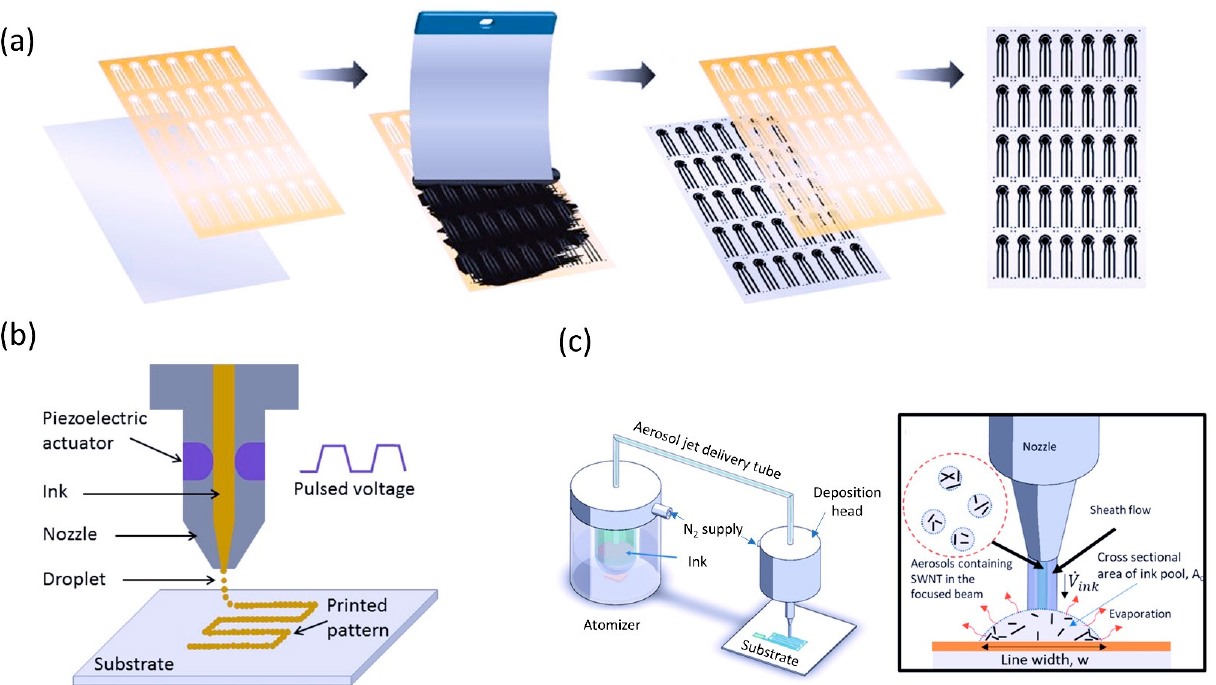
Figure 1. Printed sensor fabrication techniques ( a ) Screen-printing. Reproduced with permission from [45]. Copyright 2018 Plos ONE. ( b ) Ink-jet printing. Reproduced with permission from [46]. Copyright 2018 IOP Publishing All rights reserved. ( c ) Aerosol jet printing and its zoomed-in schematic of aerosol jet deposition. Reprinted (adapted) with permission from [47]. Copyright 2019 American Chemical Society.